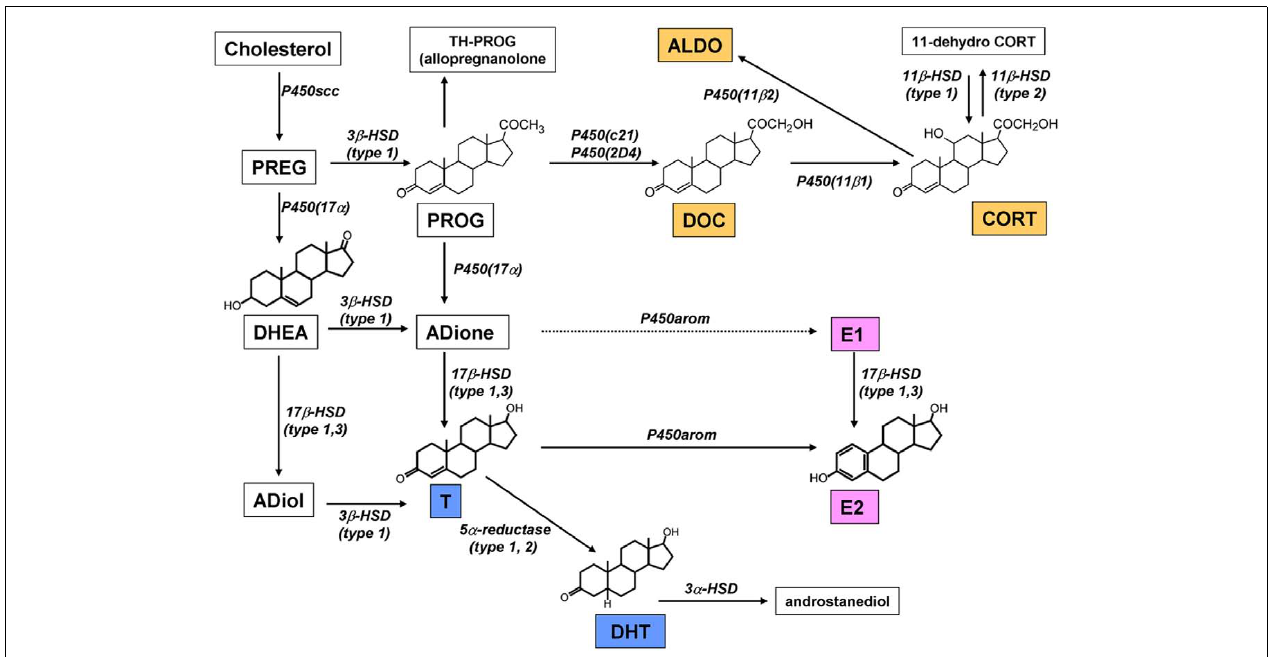
single neurons. Note that the chain arrow from ADione to E1 indicates an extremely weak conversion in male (Hojo et al., 2009).This mode of synthesis is different from that in peripheral steroidogenic